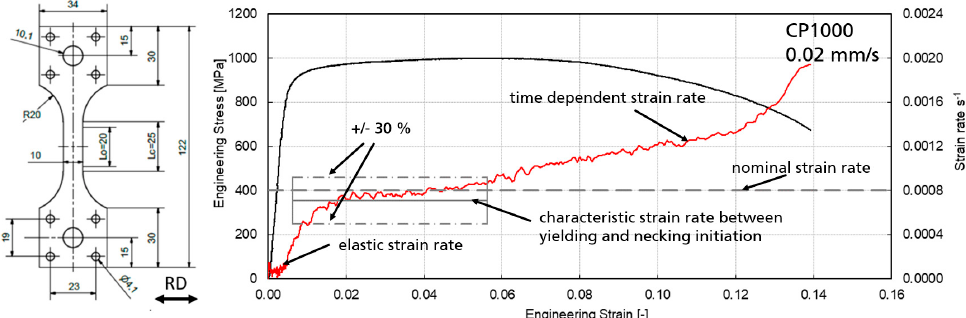
Figure 3. Geometry of tensile test specimens according to ISO 26203 ‐ 2 [24], all measurements given in mm and strain rate evolution of a CP1000 specimen tested with a test speed of 0.02 mm/s at the nominal strain rate of 0.0008 s − 1 .